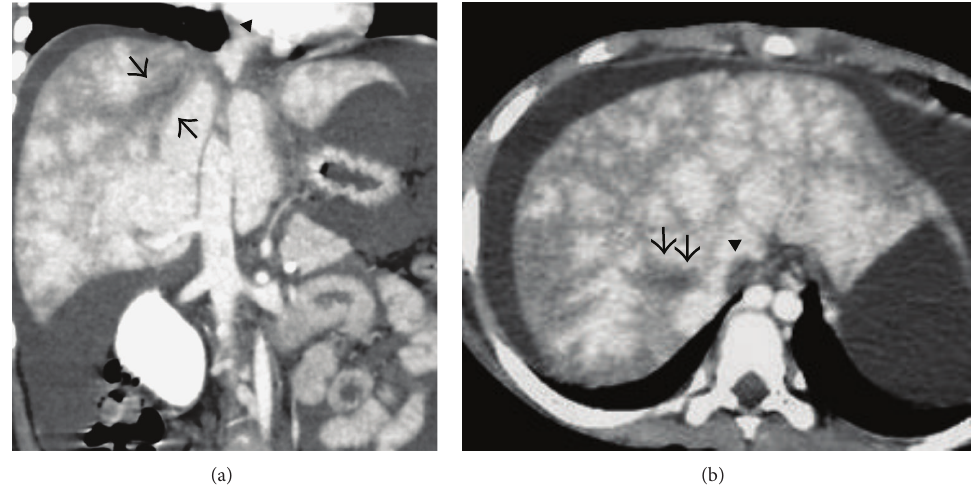
Figure 6: Coronal (a) and axial (b) portal venous phase CECT image showing thrombosed right hepatic vein (arrows) and the part of the intrahepatic portion of IVC (arrowheads) with mottled enhancement of the liver parenchyma and ascites.